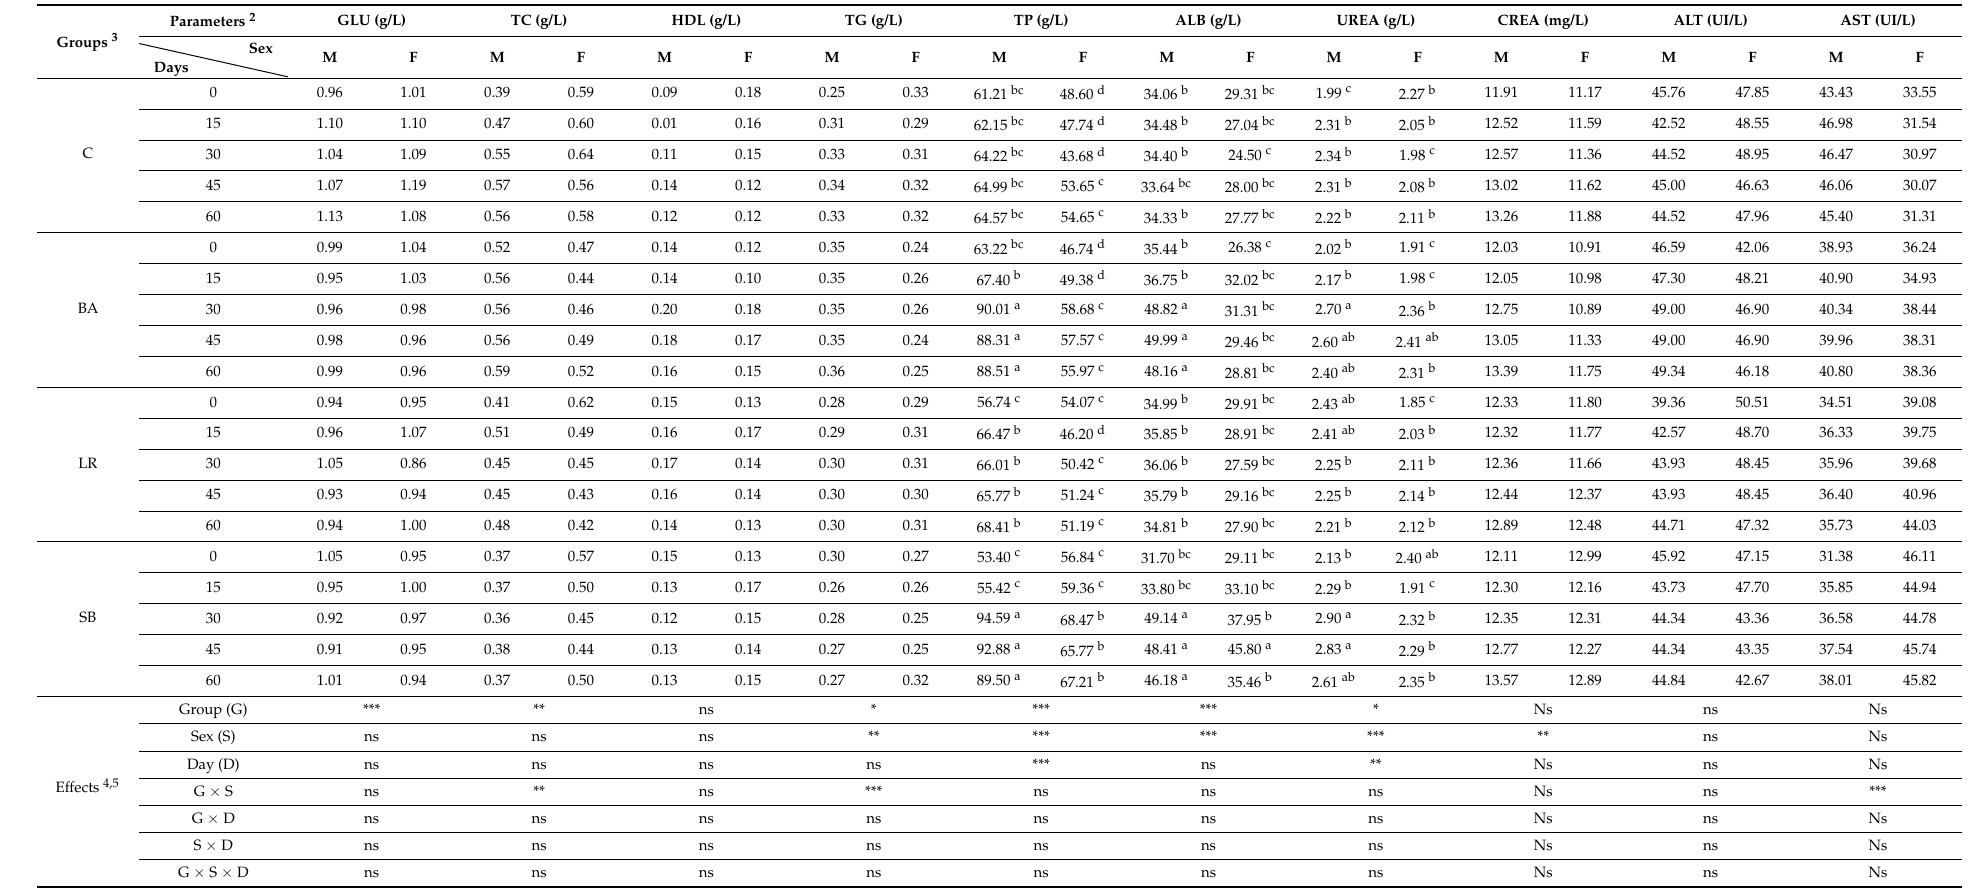
Table 1. Effects of dietary supplementation with probiotics on biochemical parameters of healthy rabbits 1